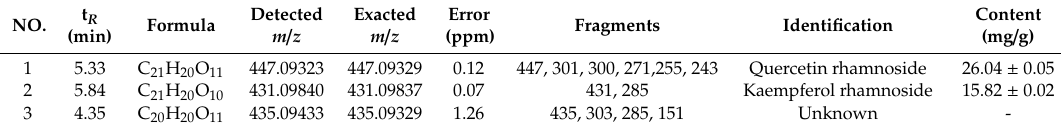
Figure 1. The UPLC-Q-ToF-MS BPI chromatogram of Lindera obtusiloba in negative mode. Table 1. Tentatively identification of major peaks detected in Lindera obtusiloba.